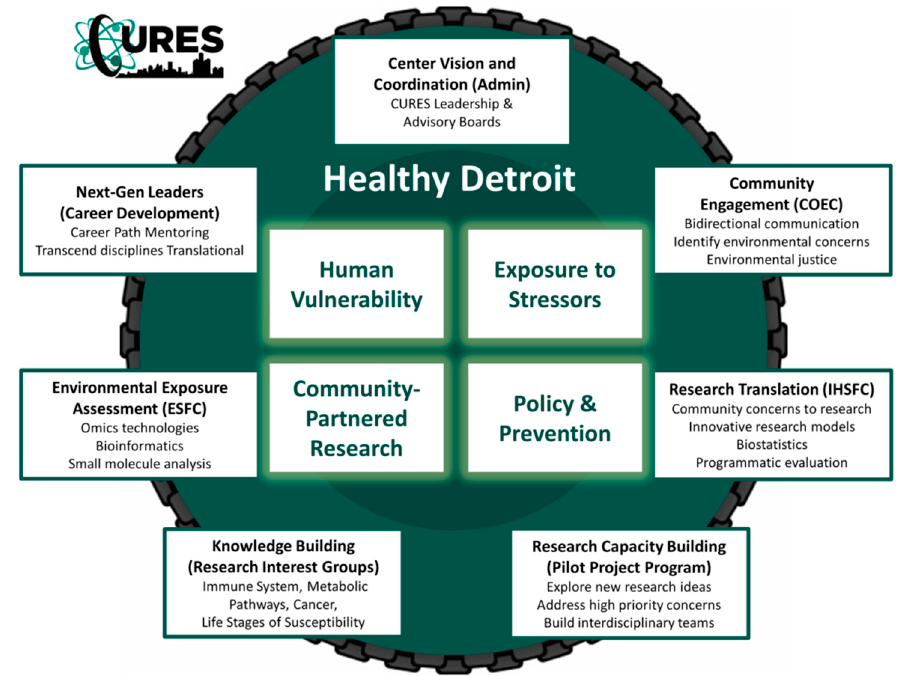
Figure 3. The Center for Urban Responses to Environmental Stressors (CURES)’ approaches to complex urban exposures and public health urban exposures and public